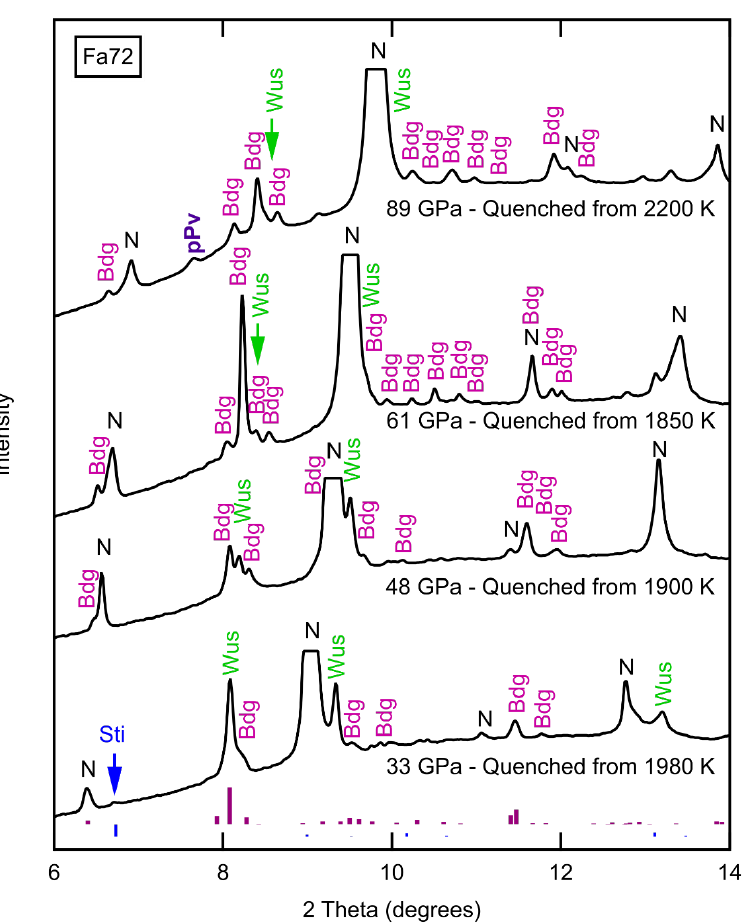
Figure 1. Diffraction patterns for phase assemblages synthesized from Fa72 at 33 – 89 GPa. Bdg = bridgmanite, pPv = post-perovskite, Wus = wüstite/magnesiowüstite, Sti = stishovite, N = NaCl medium. Due to overlap between oxide and NaCl peaks, we cannot resolve whether the structure is B1 cubic or rhombohedral, though EDX results indicate 92 – 98% FeO. Reference stick patterns for Bdg and Sti are provi ded below. For these experiments, λ = 0.3344 Å .